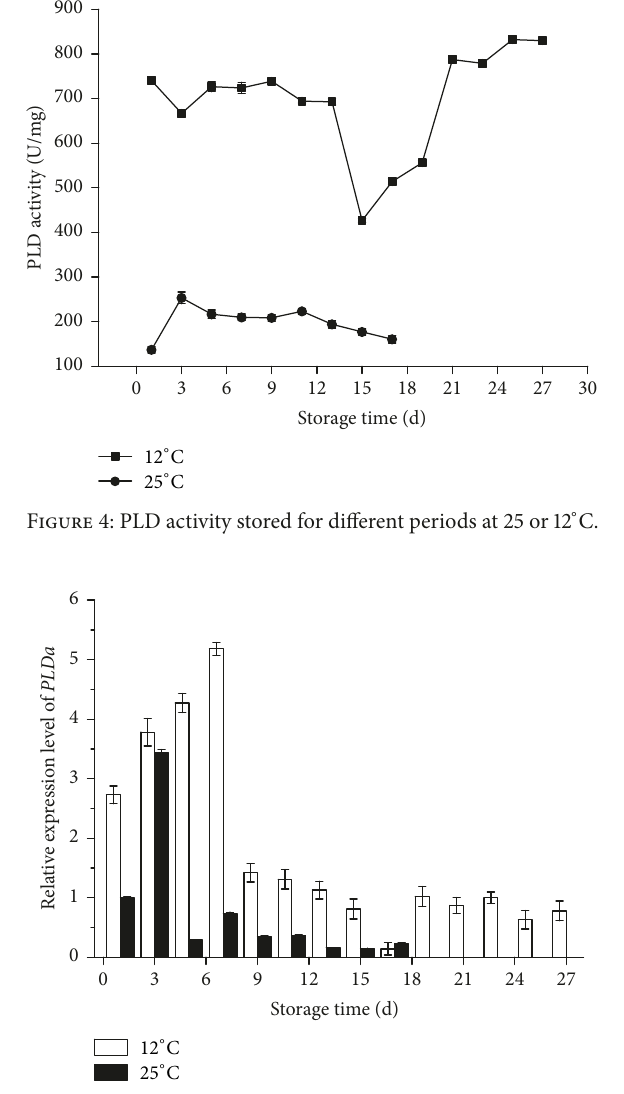
Figure 5: Expression of gene MaPLD 𝛼 at different postharvest stages at 25 or 12 ∘ C. Actin (accession number AB046952) served as an internal